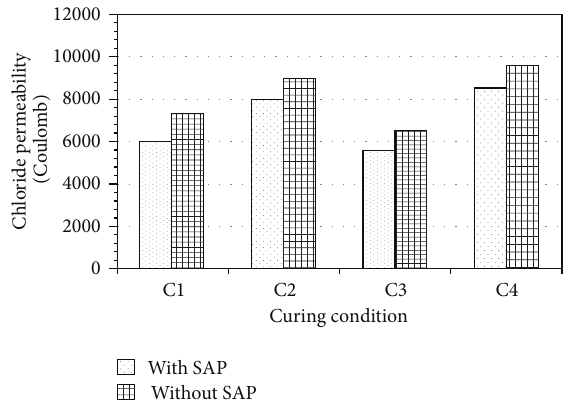
Figure 9: Test results on chloride permeability of different type of concrete.